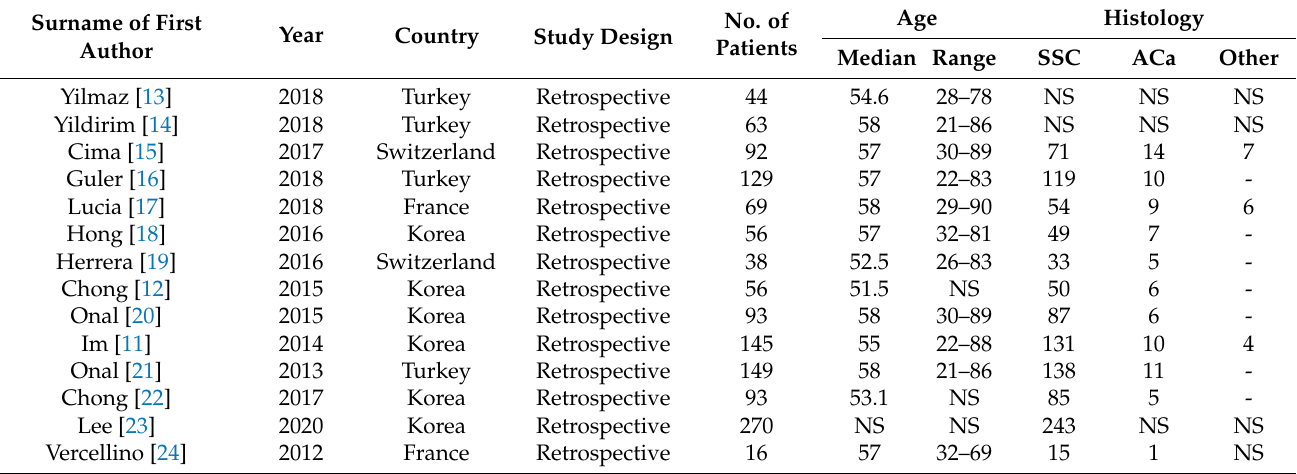
Table 1. Basic information and patient characteristics.